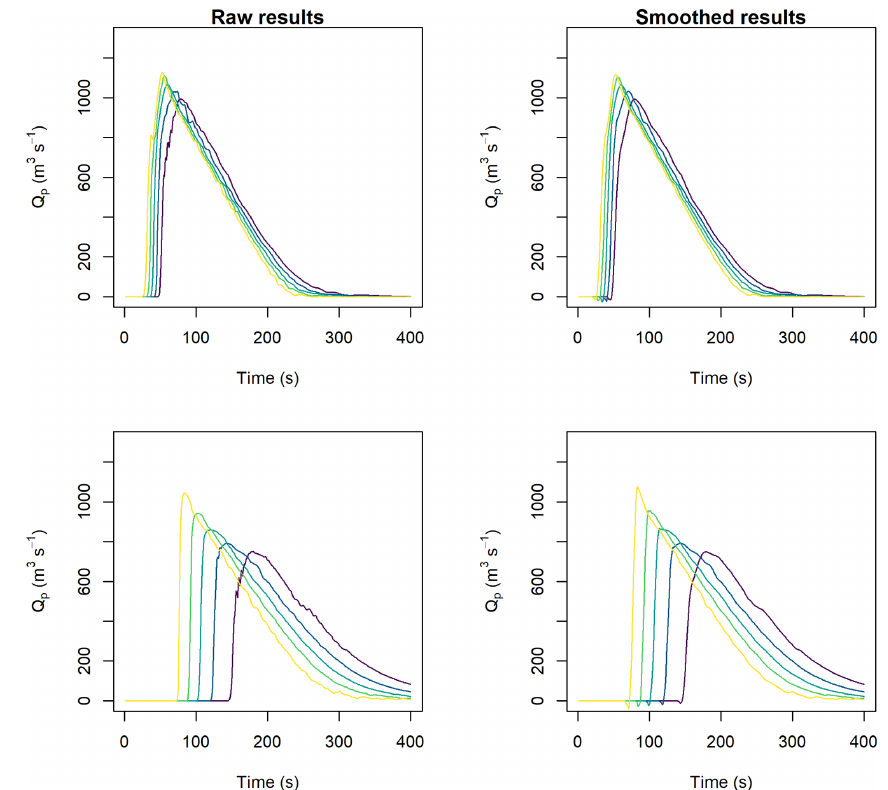
Figure A2. Raw versus smoothed model results for the numerical flume with f = 0 . 2.